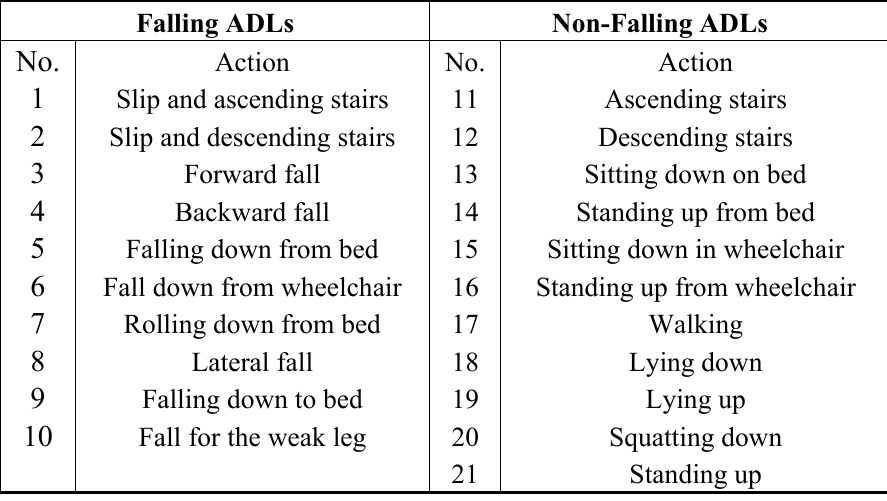
Table 2. A series of falling and non-falling ADLs.